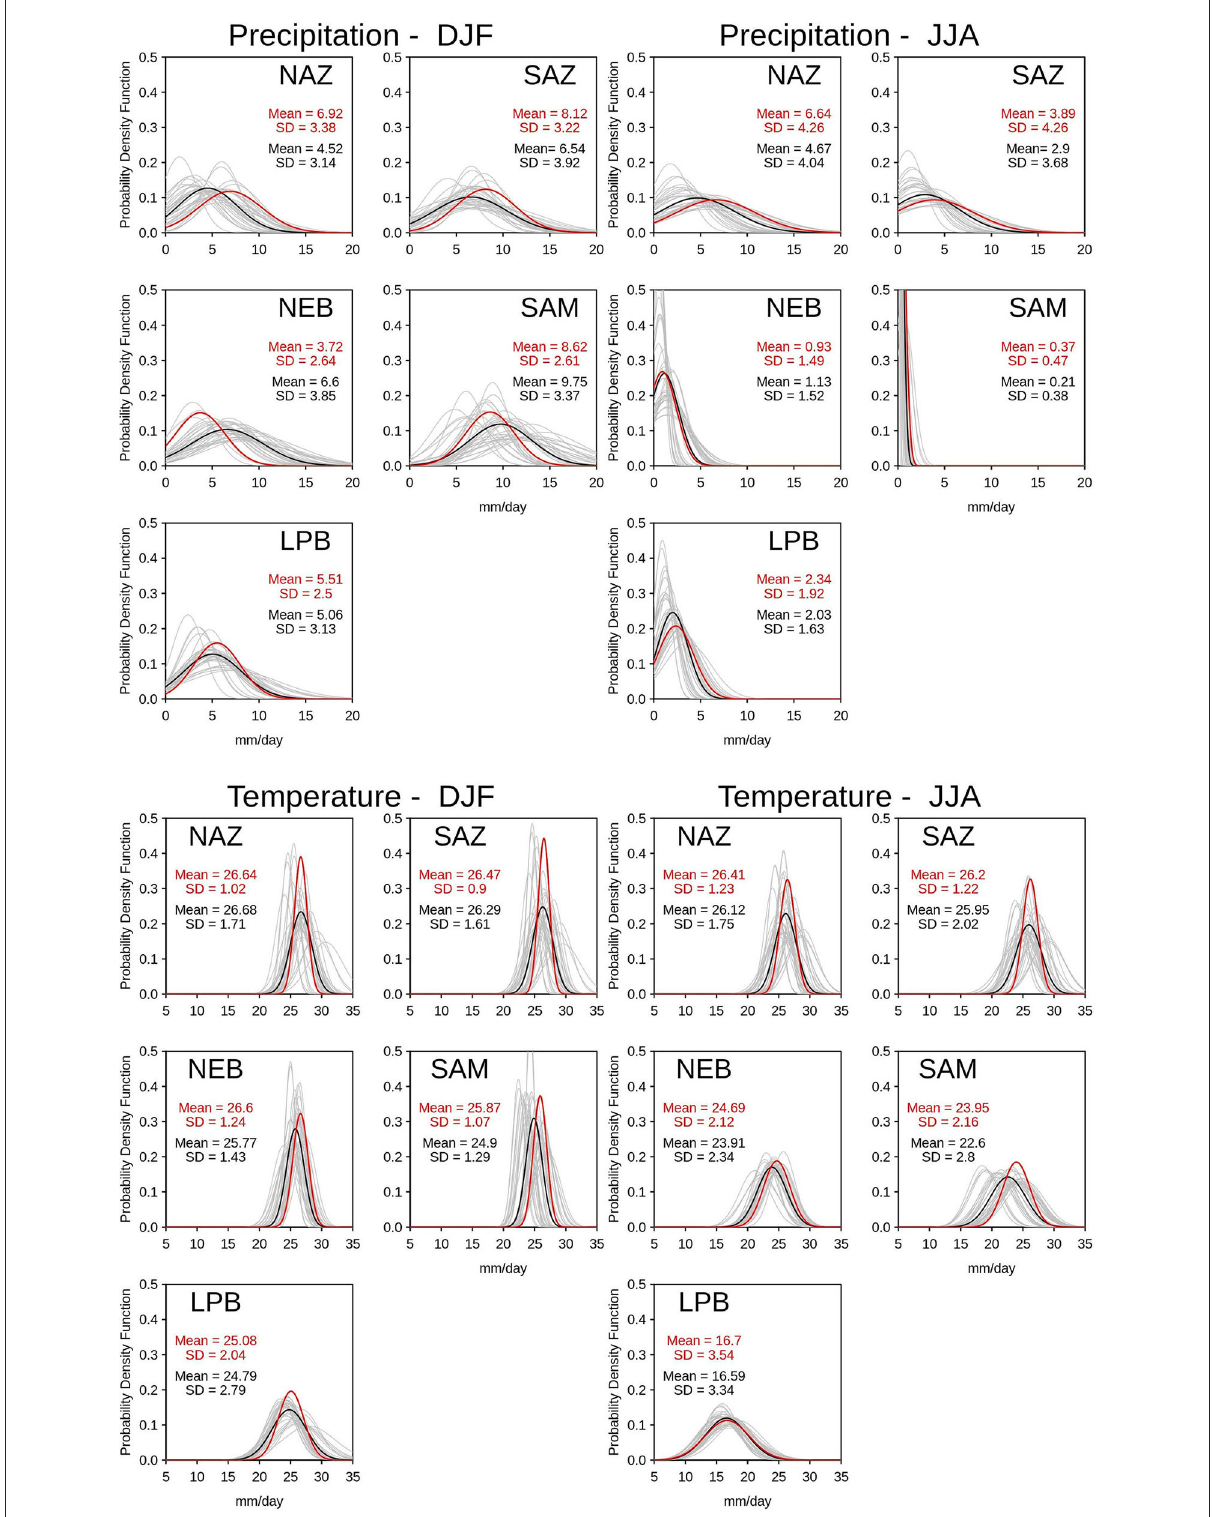
FIGURE10 Probability density functions (PDF) of seasonal precipitation (top) and temperature (bottom) for Austral summer (DJF) and winter (JJA) in comparison with observations (red line) over each sub-region in the reference period. The continuous gray lines represent PDF of all GCMs and the black line is the average PDF for the GCMs (i.e., CMIP6